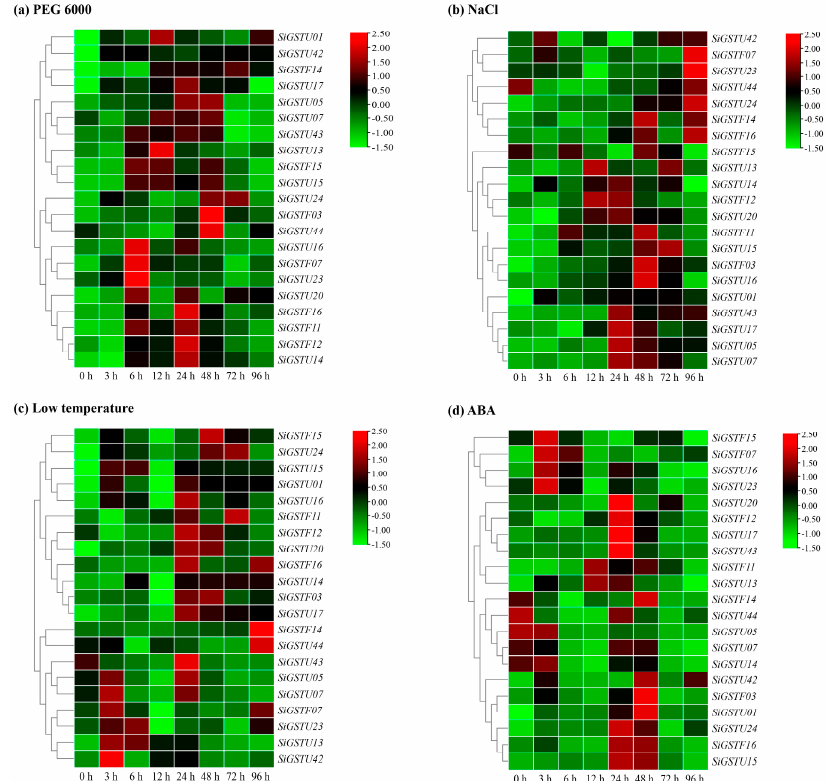
Figure 6. Relative expression patterns of 21 SiGSTs in leaves of foxtail millet under abiotic stresses and ABA treatments. Relative expression patterns of 21 SiGST genes were analyzed with qPCR under osmotic (20% PEG 6000) ( a ), salt (200 mM NaCl) ( b ), cold stress (4 °C temperature) ( c ), and 100 μ M ABA ( d ). The relative expression levels of each gene were calculated by the 2 −∆∆ Ct method. The heat map of SiGSTs expression condition was constructed by TBtools, expression value was standardized by Log2. The expression level of target gene at 0 h was used as control.